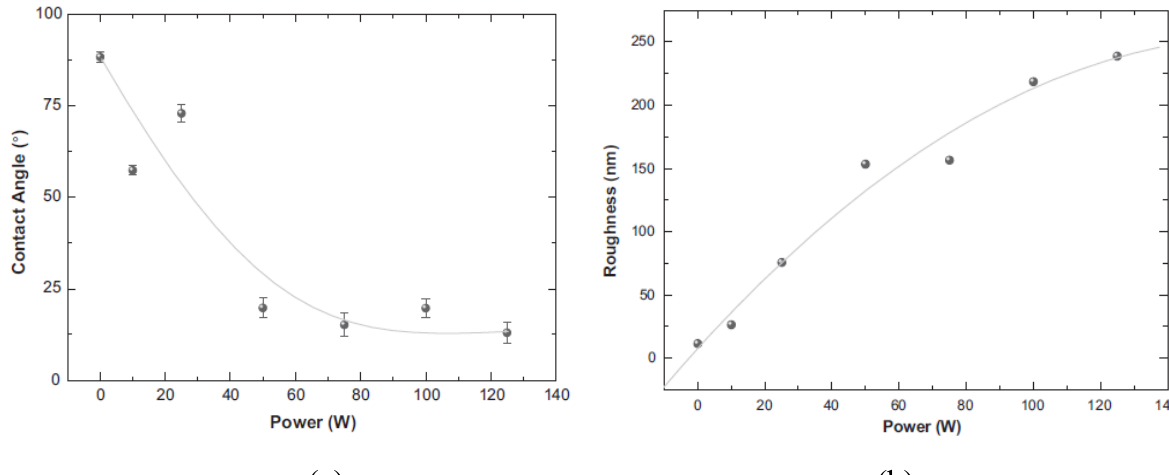
Figure 8. Water contact angle data ( a ) as well as roughness values ( b ) as a function of the plasma power (Reprinted with permission from [58]. Copyright 2011